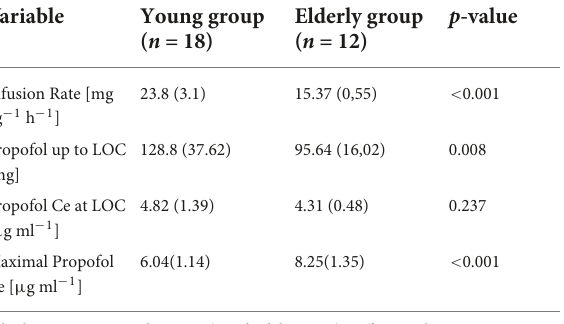
TABLE 2 Induction details.